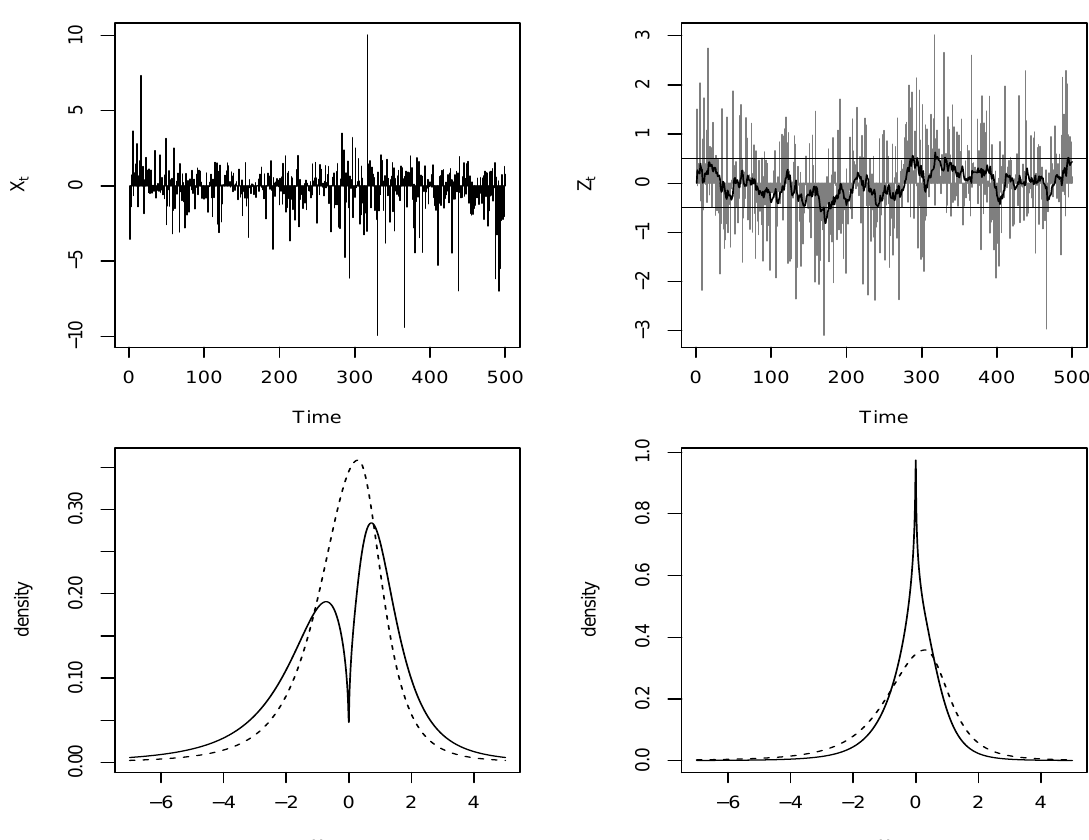
Figure 4. Top left: realization of length n = 500 of ( X t ) for a process with a marginal skewed Student distribution (parameters: ν = 3, γ = 0.8, µ = 0.3, σ = 1) a v-transform of the form (7) (parameters: δ = 0.50, κ = 0.9, ξ = 1.1) and an underlying ARMA process ( α = 0.95, β = − 0.85, σ (cid:101) = 0.95). Top right: the underlying ARMA process ( Z t ) in gray with the conditional mean ( µ t ) superimposed in black; horizontal lines at µ t = 0.5 (a high value) and µ t = − 0.5 (a low value). The corresponding conditional densities are shown in the bottom figures with the marginal density as a dashed